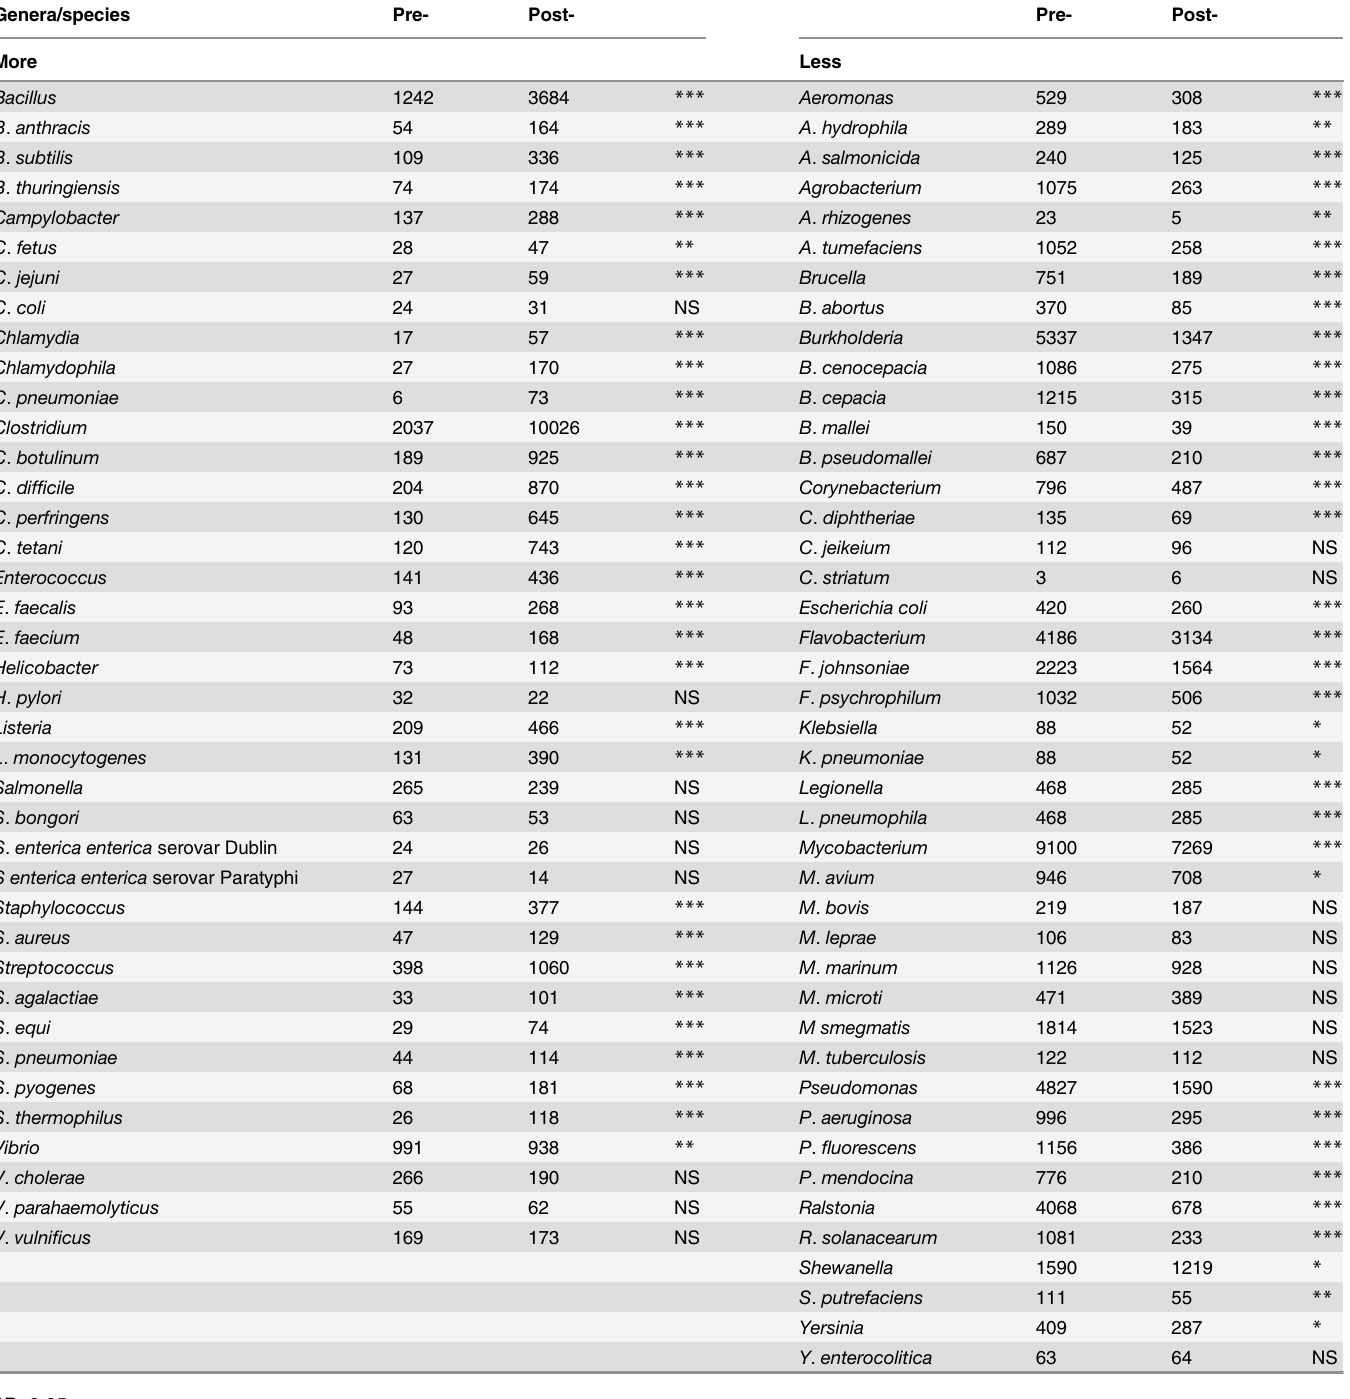
Table 5. Number of hits in metagenomic datasets matching selected species/genera containing pathogenic strains in biosolids samples from Plant A sampled on August 4, 2009. Genera/species Pre- Post-